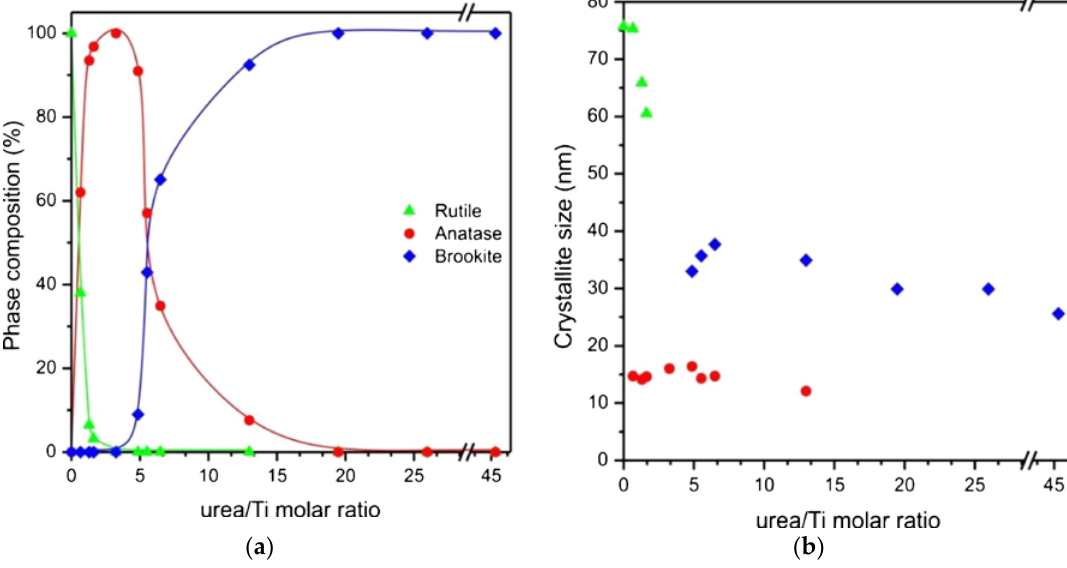
Figure 2. ( a ) Evolution of phase composition and ( b ) mean crystallite sizes as a function of the initial urea concentration. Reproduced from reference [21] with the permission of the Elsevier, 2017.